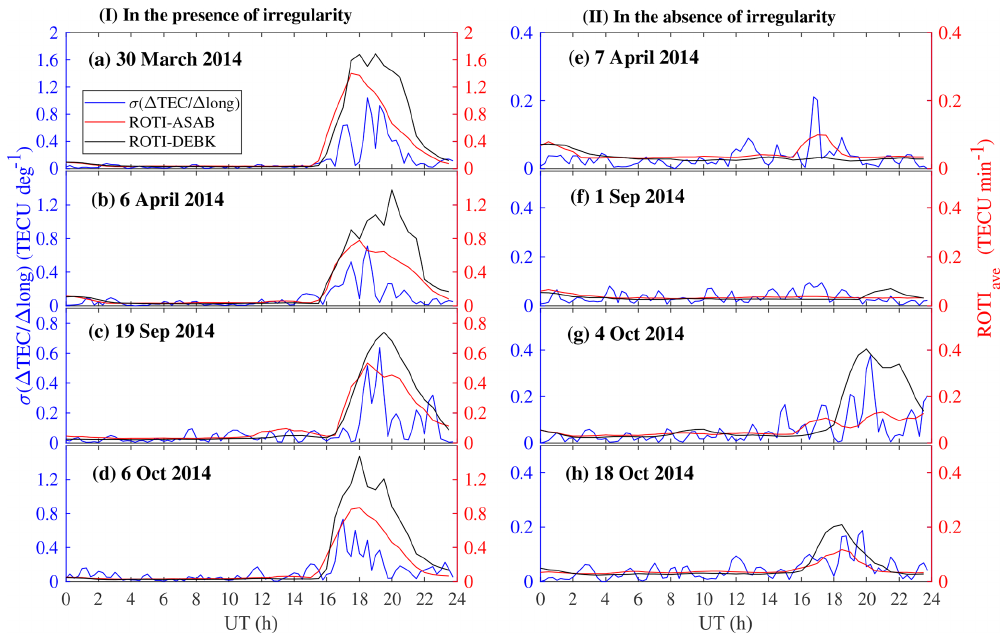
Figure 4. Typical examples of the diurnal variation of σ((cid:49) TEC /(cid:49) long ) (blue curve) and ROTI ave over ASAB (red curve) and DEBK (black curves) (I) in the presence of ionospheric irregularities on (a) 30 March 2014, (b) 6 April 2014, (c) 19 September 2014 and (d) 6 October 2014 and (II) in the absence of ionospheric irregularities on (e) 7 April 2014, (f) 1 September 2014, (g) 4 October 2014 and (h) 18 October 2014. Local time (LT) = UT +